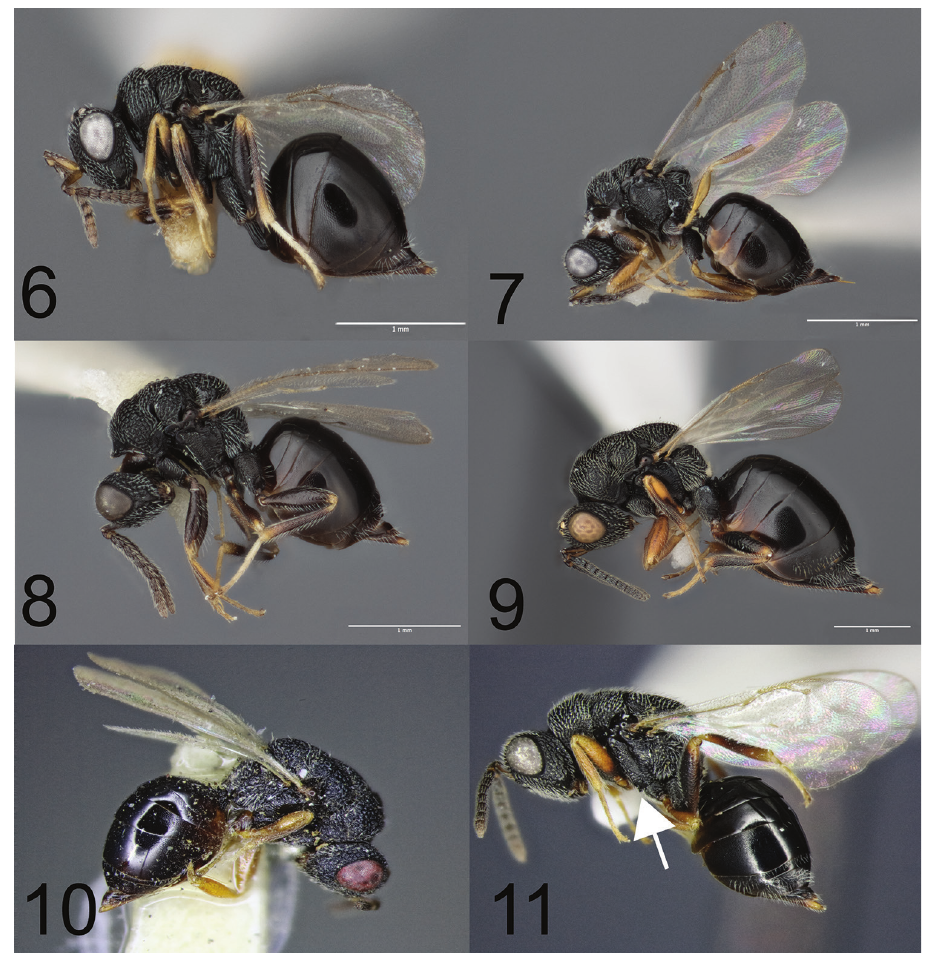
Figures 6–11. Tenuipetiolus ruber 6 Female habitus. Eurytoma iniquus 7 Female habitus. E. longavena 8 Fe- male habitus. E. discordans 9 Female habitus. E. imminuta 10 Female habitus (length 2.0 mm). E. spongiosa 11 Female habitus (length 3.2 mm), arrow pointing to precoxal tooth formed by the adscrobal